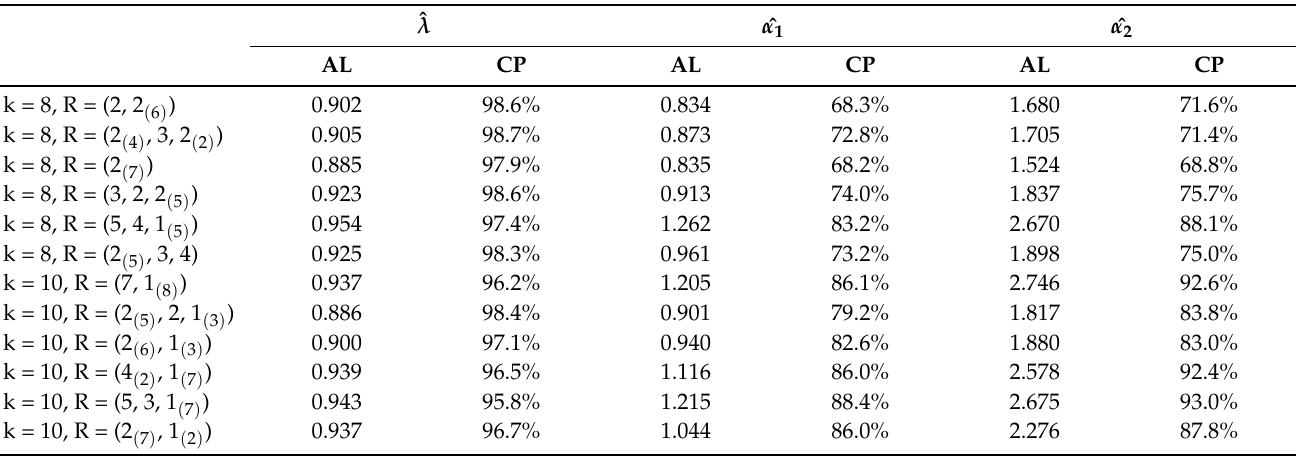
Table 3. CPs and ALs of 95% asymptotic confidence intervals of the model parameters with λ = 0.5, α 1 = 0.4, and α 2 = 0.8 based on different